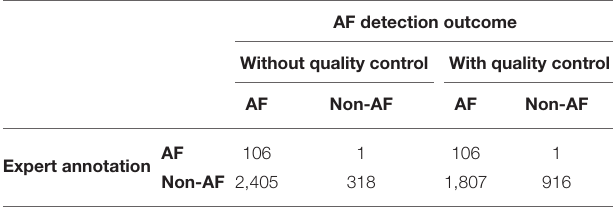
TABLE 6 | AF detection performance with and without quality control using optimal parameter values. Without quality control N = 8, α = 0.07, η = 0.55 With quality control N = 4, α = 0.04, η = 0.65